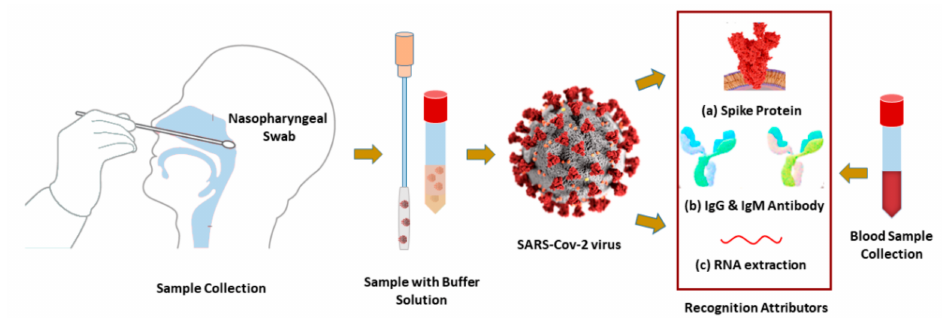
Figure 1. Schematic diagram of diagnosis biomarkers: ( a ) SARS-CoV-2 virus spike protein RBD, ( b ) IgG or IgM antibodies, and ( c ) or RNA-oligonucleotides are collected from nasopharyngeal swabs or human